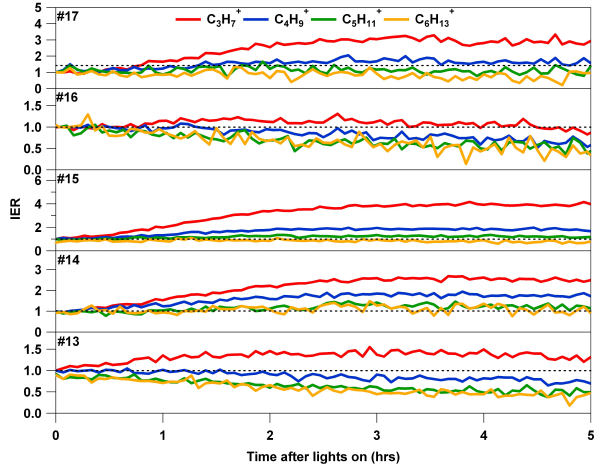
Fig. 6. Temporal evolution of the ion enhancement ratios of selected markers of primary organic